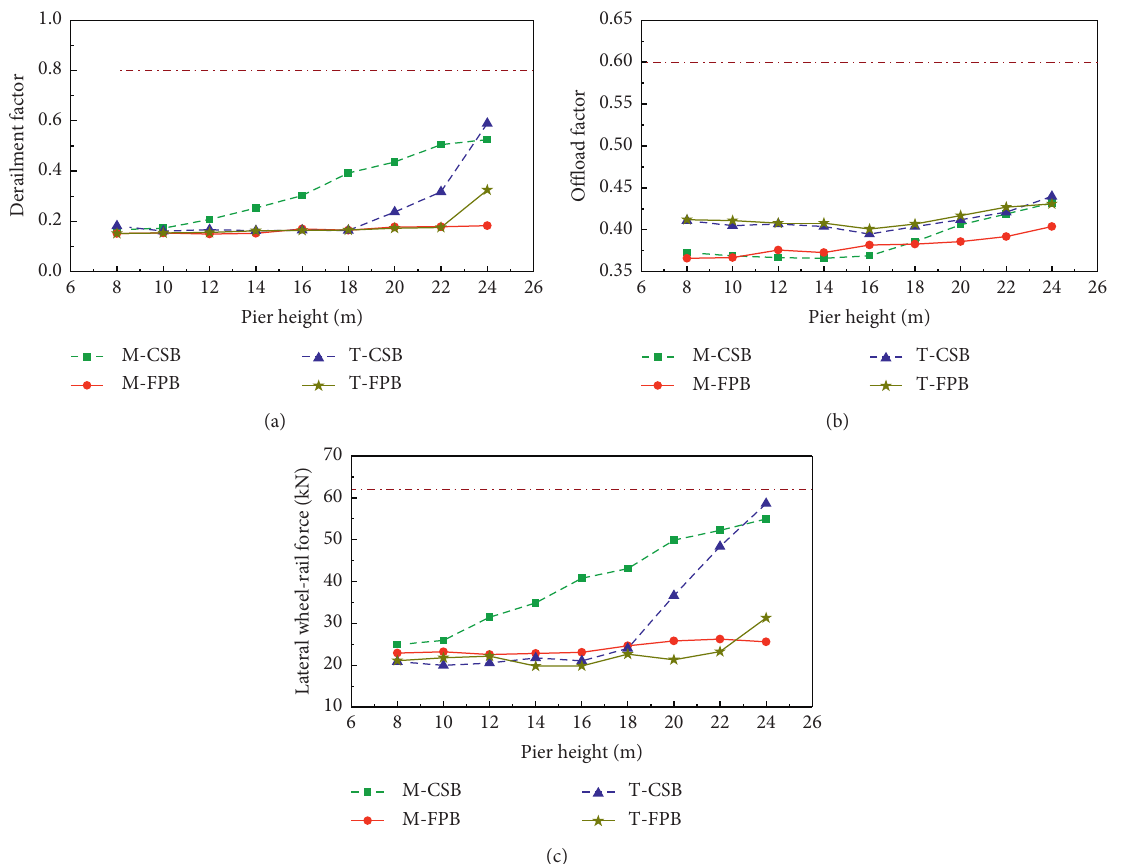
Figure 14: Distributions of running safety indices of the train versus pier height. (a) Derailment factor. (b) Offload factor. (c) Lateral wheel- rail